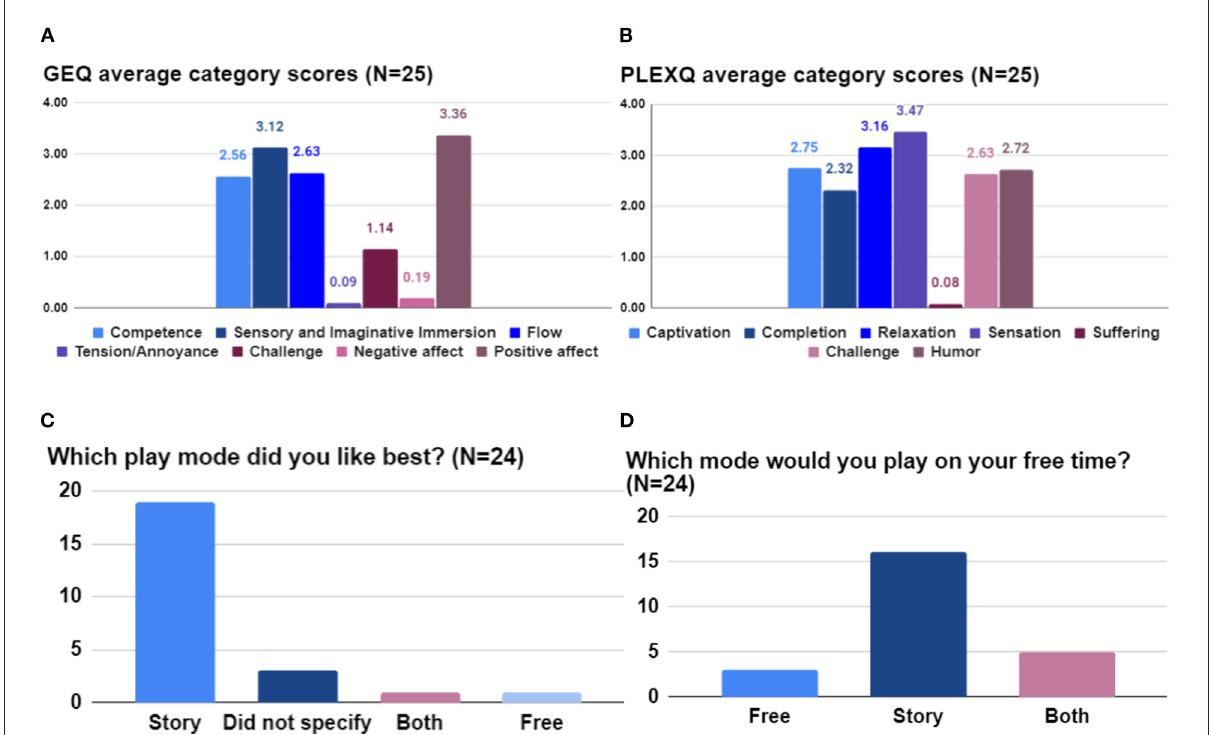
FIGURE9 Participants’ scores and preferences. Panel (A) shows the GEQ average category scores, panel (B) shows the PLEXQ average category scores, panel (C) shows participants’ favorite playing modes and panel (D) shows participants’ preferred mode to play in their free